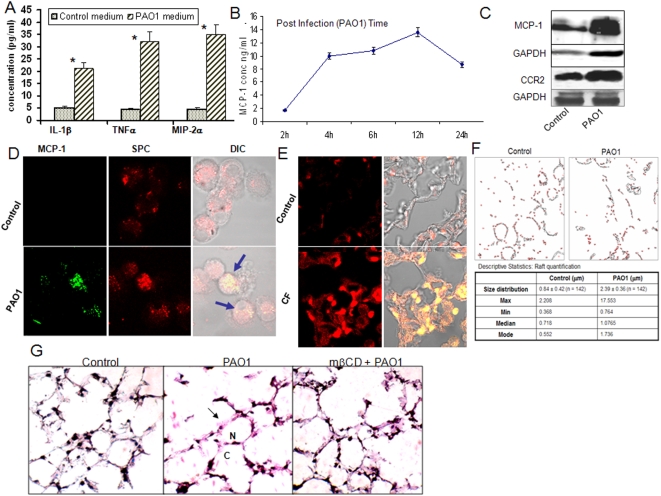
MCP-1 from AECII was a major regulator by PAO1 infection.(A) Increase of various proinflammatory factors at 24 h following stimulation with the conditioned medium from AECII infected by PAO1. (B) MCP-1 was significantly increased in a time dependent manner by the conditioned medium. (C) Both MCP-1 and its receptor of CCR2 were increased in AECII by PAO1 infection detected by western blotting. (D) Primary AECII secreted MCP-1 that was colocalized (arrows) with SP-C (a specific marker of AECII) as analyzed by immuno-fluorescence (anti-pro-SP-C from Dr. Jeffrey Whitsett). (E) Increase of MCP-1 expression in the AECII cells in human samples from Cystic Fibrosis (CF) patients (one of the 6 representative) stained by immunofluorescence. (F) Lipid raft quantification using Image J software. The colocalized pixels were identified and threshold defined vs. background. The image was converted into binary format and the “analyze particle tool” used to identify raft ranging in size of 15–255 pixels (correlates with 50–200 nm). (G) Blockade of lipid rafts with mβCD significantly reduced the secretion of MCP-1 in the lung vs. the control. The frozen sections for the lung tissue of C57BL6 mice (5 mice/group) were stained by anti-MCP-1 antibodies from Santa Cruz (arrows showing the positive staining). The results are representative of three experiments.